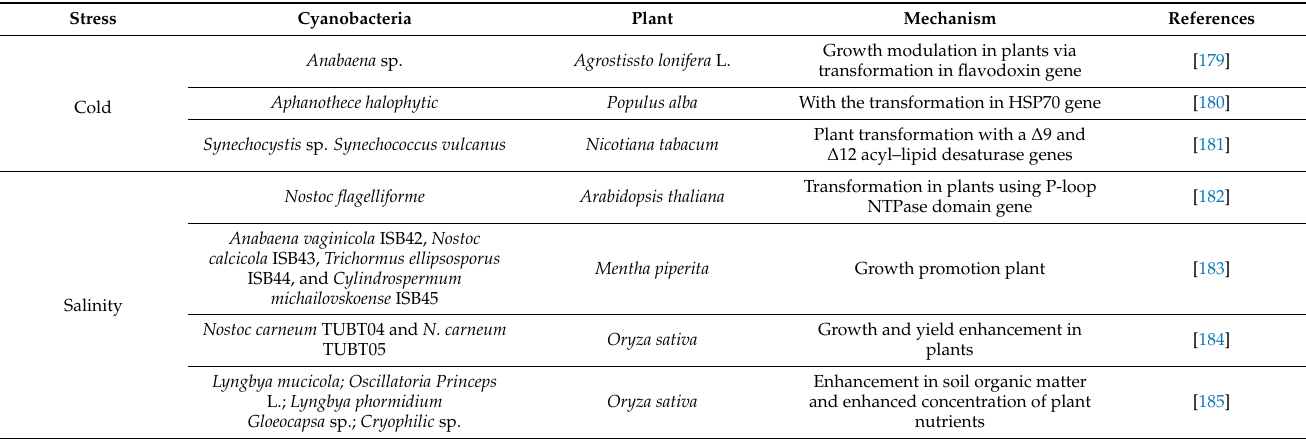
Table 3. Role of cyanobacteria and its mechanism in imparting abiotic stress tolerance in